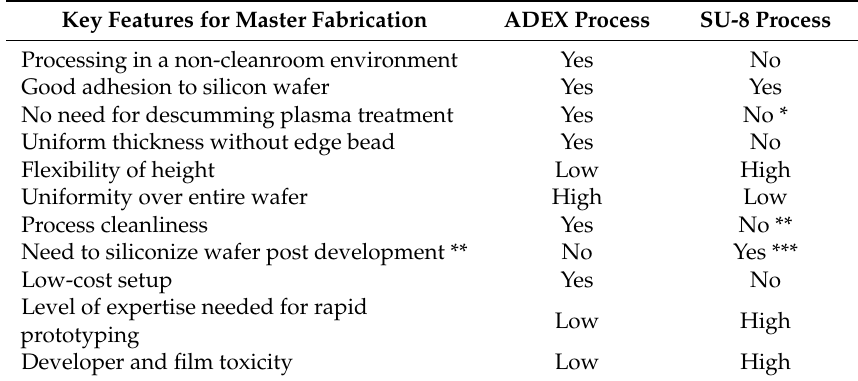
Table 2. Comparison of ADEX and SU-8 photoresists for microfluidic device